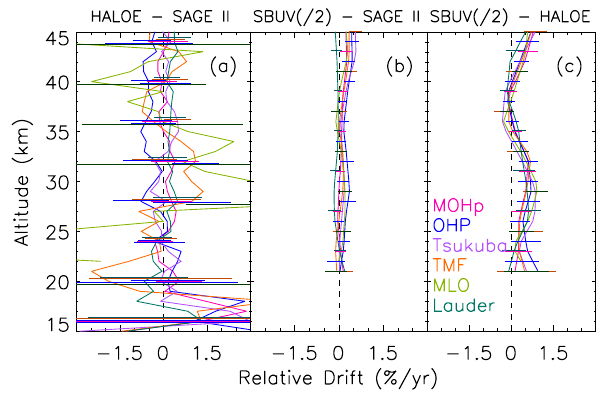
Fig. 6. (a) The drifts of HALOE in comparison with SAGE II (cid:17) (cid:16) at various stations. as reference 100 × HALOE − SAGE II SAGE II (b) The drifts of SBUV(/2) with SAGE II as reference (cid:16) (cid:17) − SAGE II 100 × SBUV (/ 2 ) . (c) Same as (b), but with HALOE SAGE II (cid:17) (cid:16) − HALOE . The error bars represent as reference 100 × SBUV (/ 2 ) HALOE twice the standard deviation of the slope.